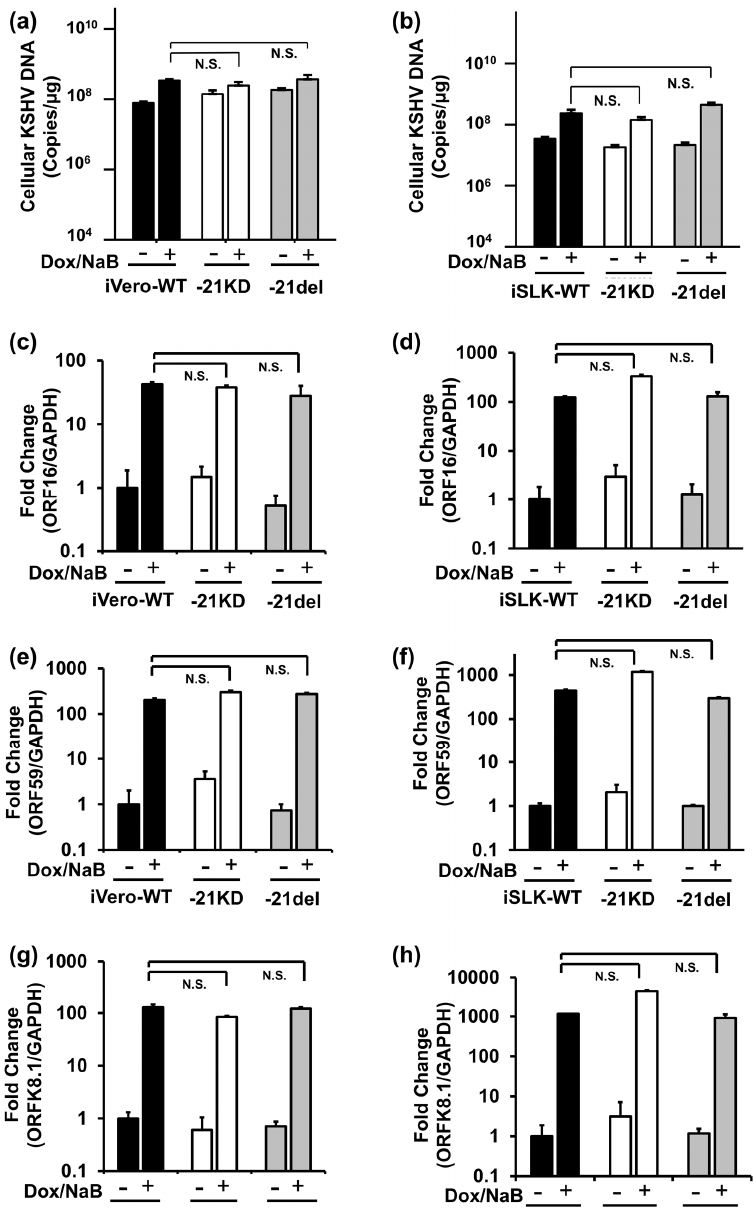
Figure 3. The effects of ORF21 and ORF21-kinase activity on the replication of intracellular viral DNA and the transcription of the lytic genes. Viral DNA replication ( a , b ) and viral gene transcription ( c – f ) in iVero (or iSLK) cells harboring WT-BAC16, 21KD-BAC16, and 21del-BAC16. The recombinant BAC16-transfected iVero cells ( a , c , e , g ) or iSLK cells ( b , d , f , h ) were treated for 48 h with Dox and NaB to induce lytic replication, and DNA genomes containing viral DNA were prepared from harvested cells. ( a , b ) The copies of intracellular viral DNA in the lytic-induced cells were measured using real-time PCR and normalized by the total amount of obtained DNA. ( c – h ) Quantities of mRNA expression levels of viral genes, immediate-early gene: ORF16 (vBcl-2); early gene: ORF59 (DNA processivity factor); late gene: K8.1 (glycoprotein) in the mutated KSHV-harboring cells. The total RNA was purified from lytic-induced cells and was subjected to RT real-time PCR. The values obtained from Dox- and NaB-untreated iSLK (or iVero)-WT cells were defined as 1.0. Statistical analysis was performed between Dox/NaB(+) groups in RT-qPCR. These results were not detected to have a statistically significant difference. ( a – h ) N.S., not